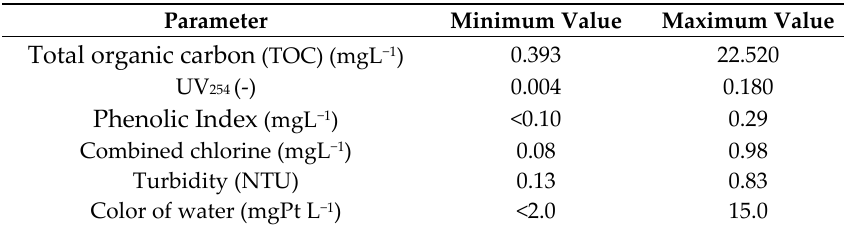
Table 1. Indicators of organic contamination in 50 tested swimming